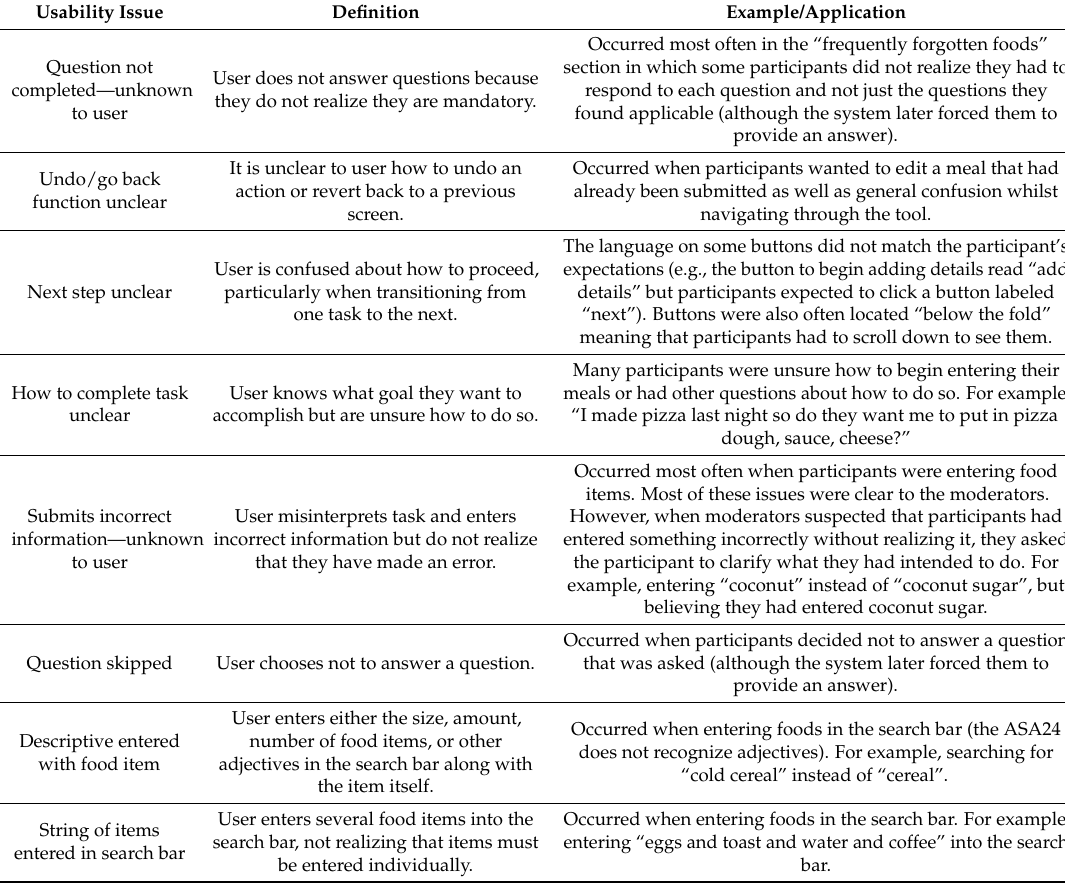
Table 3. Descriptions and examples of usability issues related to Effectiveness.